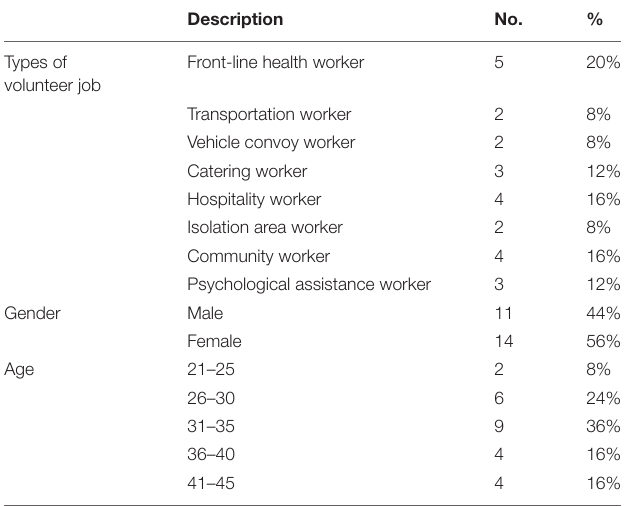
TABLE 1 | Personal profiles of interviewees in study 1 ( N =